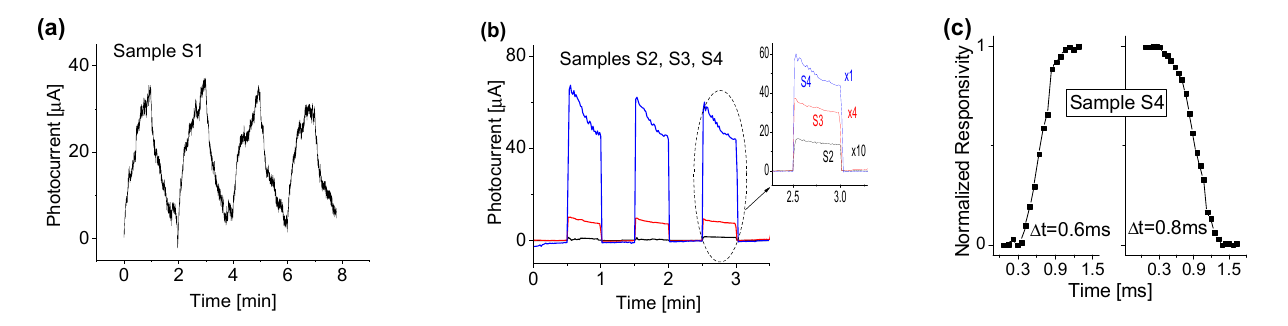
Figure 8. UV response of samples ( a ) S1 and ( b ) S2–S4 based prototypes at a bias of 2 V and room temperature. ( c ) Normalized time response of sample S4.